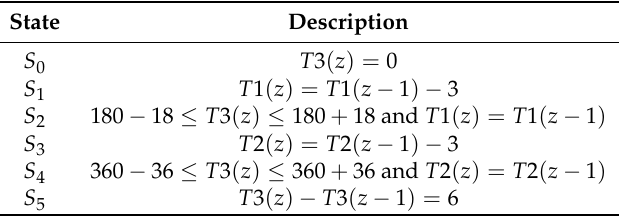
Table 3. Description of